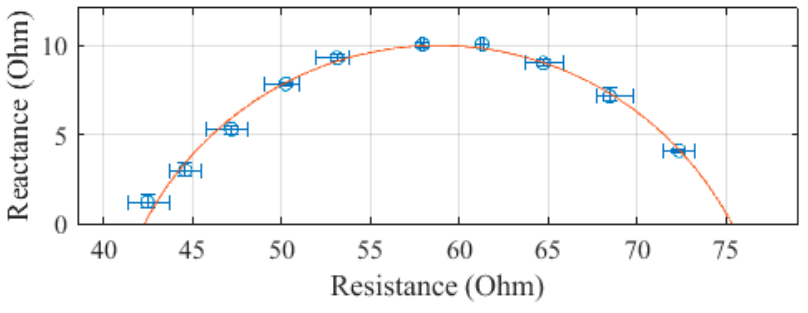
Figure 6. Cole–Cole plot of the trunk impedance of subject 1 measured with the SBISD.